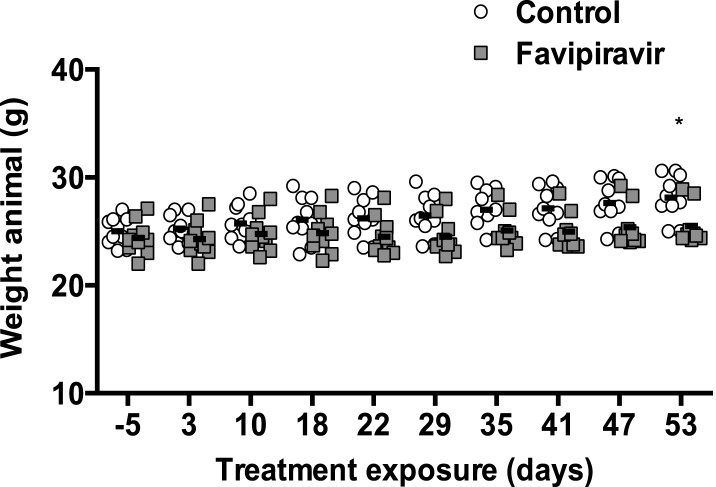
Reduced weigh increase in favipiravir-treated mice.They are represented animal weights before (−5) and during the treatment with placebo or favipiravir (*; p < 0.05; 2-way ANOVA test).